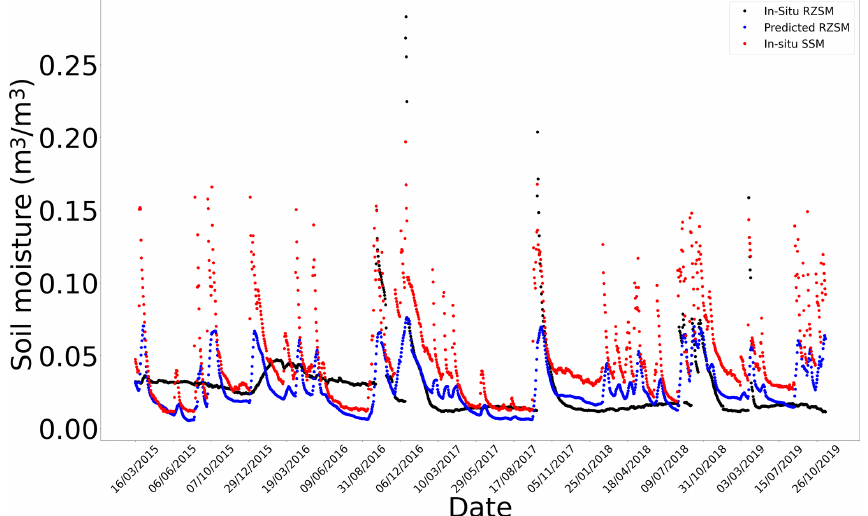
Figure G3. In situ SSM, in situ RZSM, and predicted RZSM series at station Barrouta_160 (Tunisia) with model ANN_SSM.